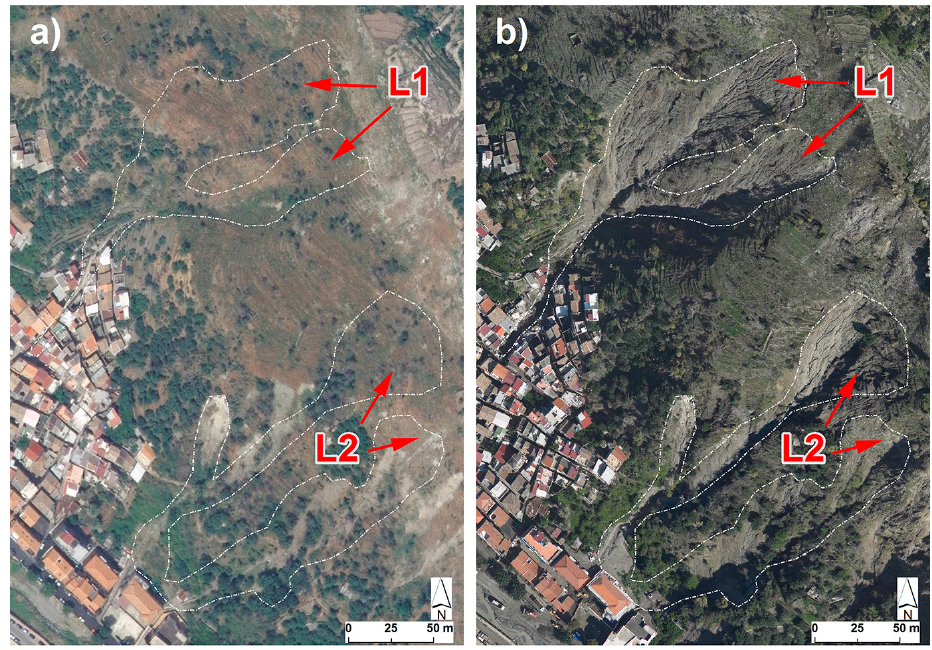
Figure 3. Comparison of aerial photographs taken before (a) and after the storm (b) , showing landslides L1 and L2, upslope Giampilieri village.